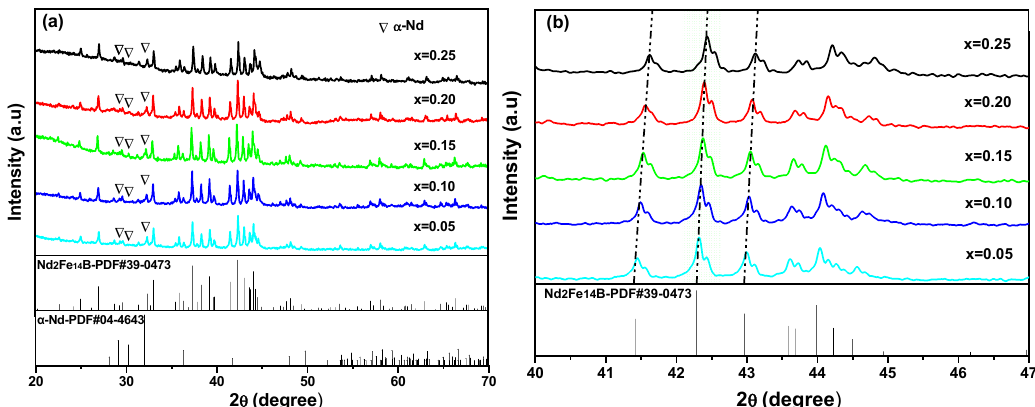
Figure 1. XRD powder patterns ( a ) and local XRD patterns ( b ) of (Nd 1-2x Ce x Y x ) 14.5 Fe 79.3 B 6.2 alloys annealed at 1173 K for 360 h.